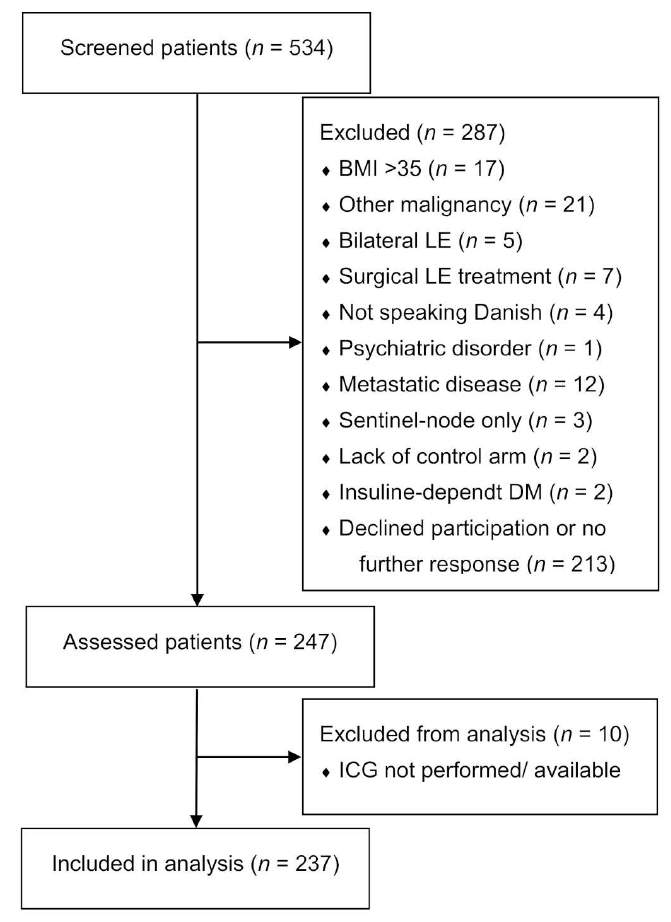
Figure 1. This figure shows the flowchart of included